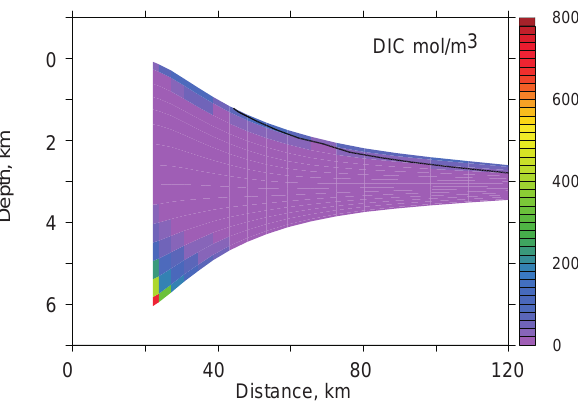
Fig. 10. Bubble concentration (percent pore volume) for the Base scenario, with various other scenarios in the Supplement file bub- bles.pdf. Solid black line is the hydrate stability boundary. An ani- mation of the Base and Bumpy scenarios can be seen at http://geosci. uchicago.edu/ ∼ archer/spongebob active/bubbles.active.movie.gif. direction, about the middle of the wedge. The isotopic com- positions of DIC and CH 4 are both systematically heavier in the inshore core than they are near the toe of the wedge.